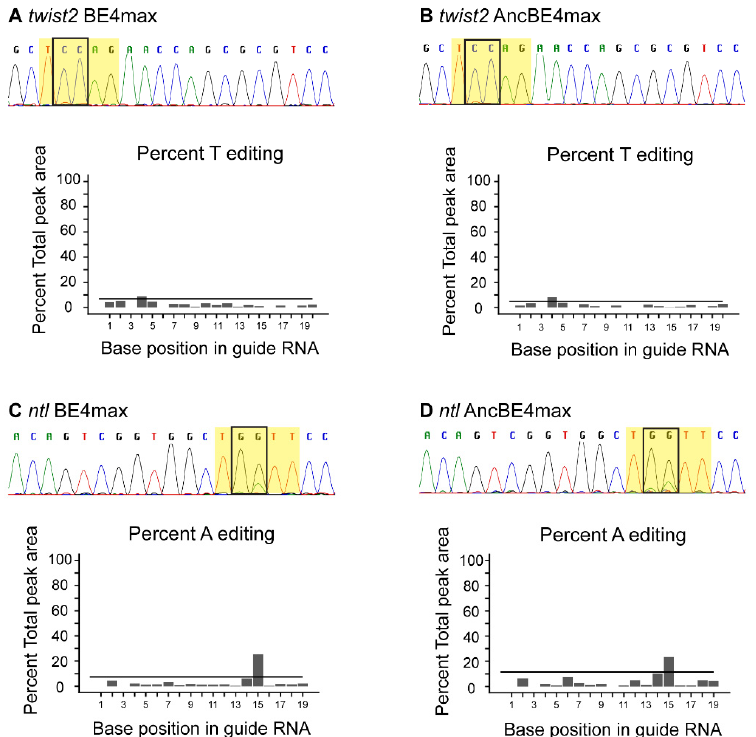
Figure 3. Somatic base editing with BE4max and AncBE4max. ( A , B ) somatic base editing at twist2 locus with BE4max ( A ) and AncBE4max ( B ). ( C , D ) somatic base editing at ntl locus with BE4max ( C ) and AncBE4max ( D ). In all panels, partial sequence chromatograms of representative embryos are shown with the target window highlighted in yellow and target nucleotides boxed. EditR Quad plots for the expected edited allele are shown below each chromatogram. These plots show the percent editing (Y-axis) at each nucleotide by base position (X-axis), with a horizontal line representing the P- value cutoff of 0.01. Any nucleotide above this cutoff is considered a real secondary peak. Expected base pair changes are C → T for twist2 or G → A for ntl ( ntl sgRNA is on the reverse strand and orientation shown here is to depict the open reading frame). Table 2. Details of screening for somatic base editing.